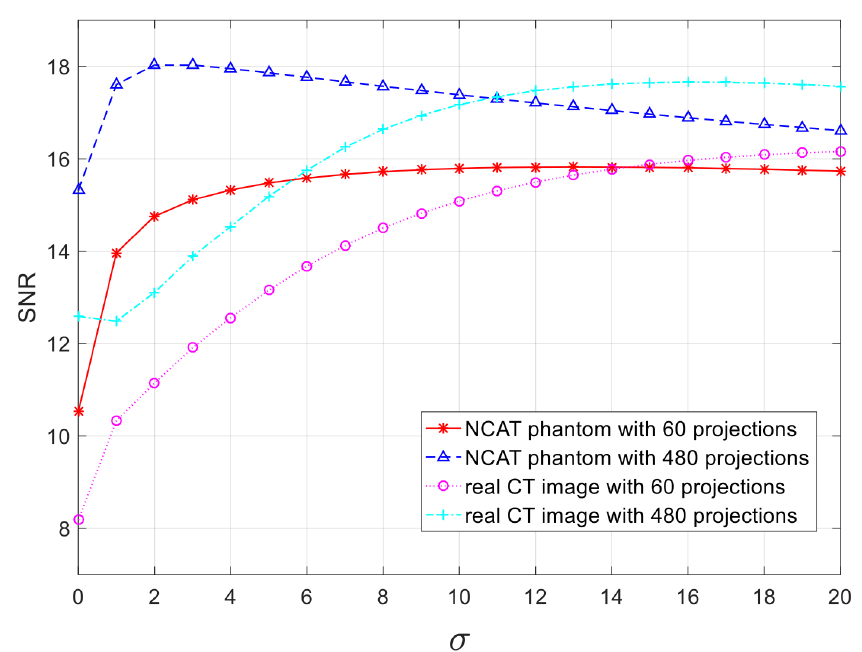
Fig 6. SNR performance with different σ